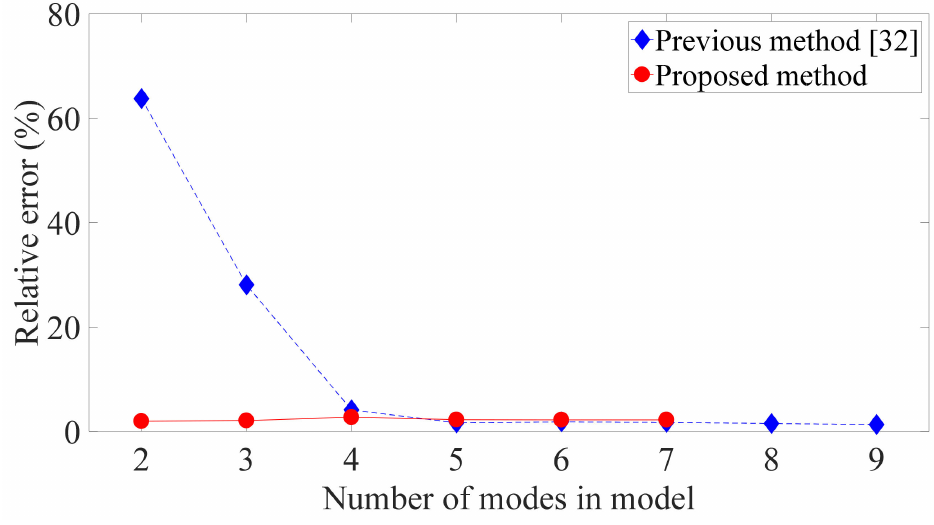
Figure 7. Relative error of first floor’s peak inter-story drift of nine-DOF structure for different numbers of modes in model when only one accelerometer is